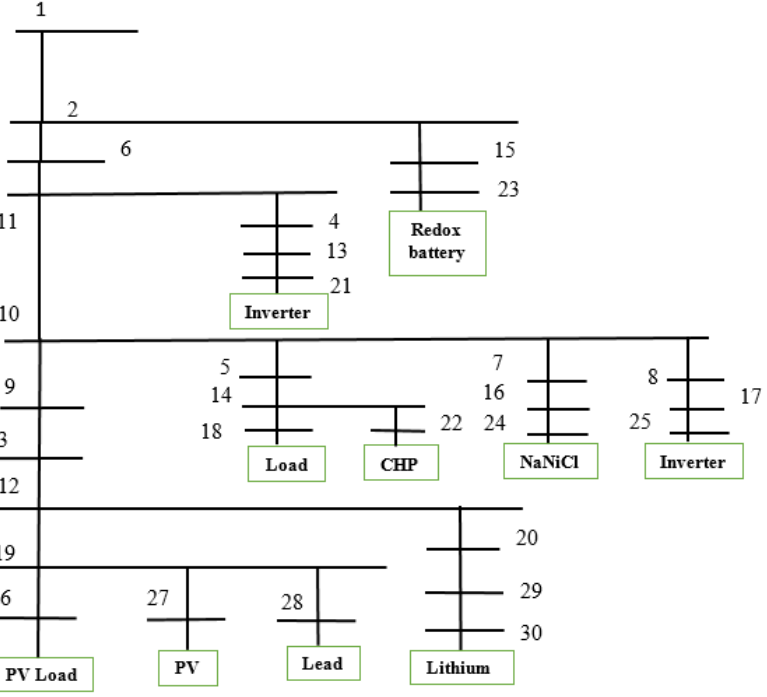
Figure 3. Single line diagram of the grid connected test case.